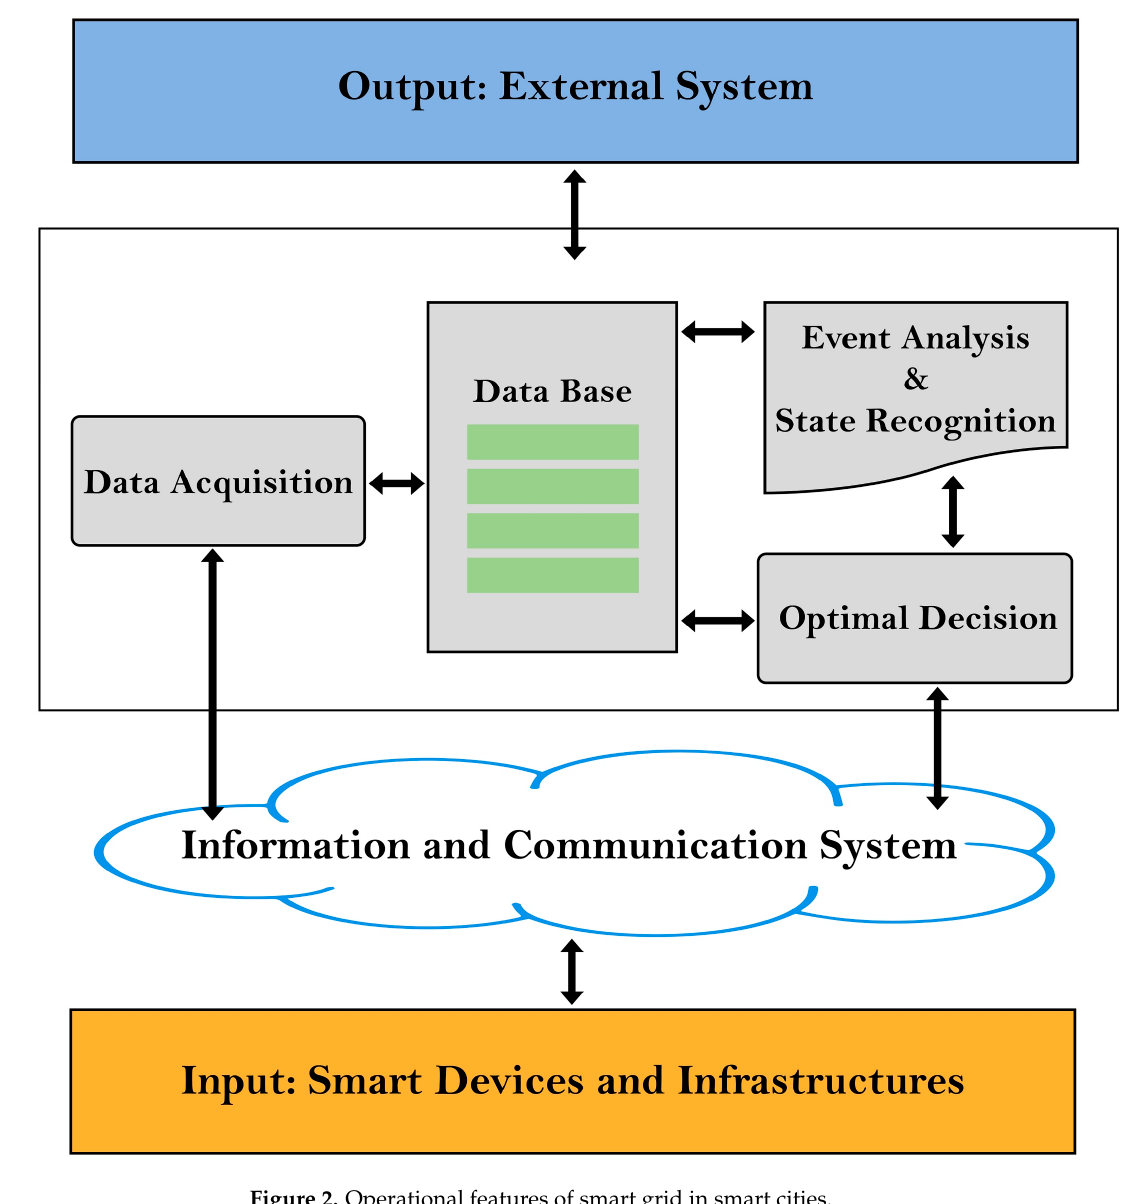
Figure 2. Operational features of smart grid in smart cities.